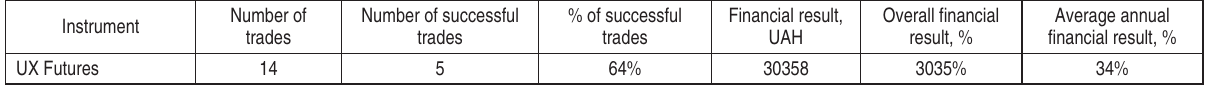
Table 9. Trading simulation results for the Halloween effect (PFTS index)